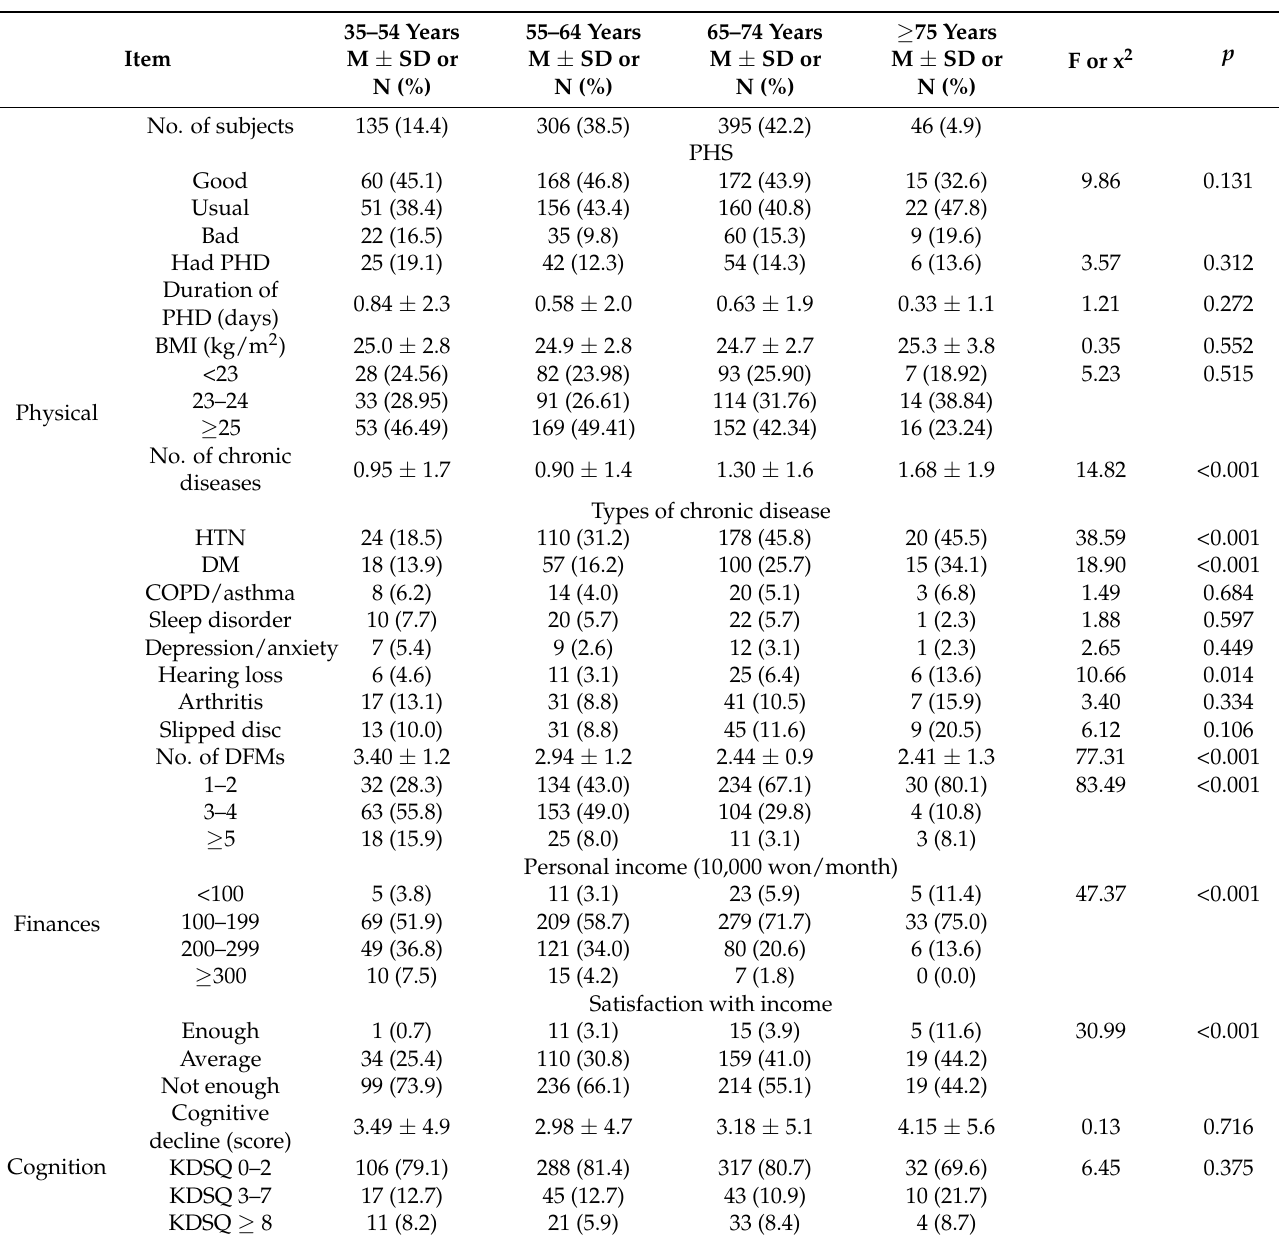
Table 1. General characteristics of taxi drivers. n =